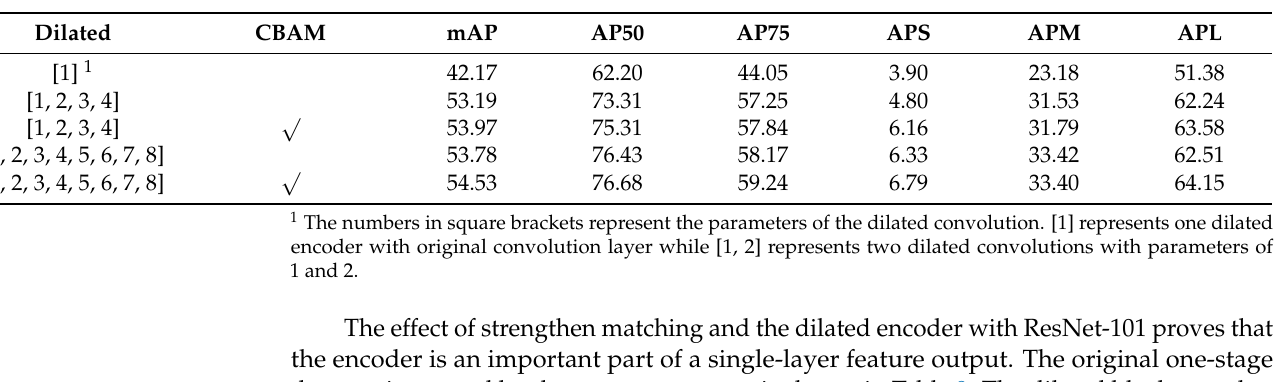
Table 8. Ablation study for the DIOR dataset. Effect with the different dilated block parameters and attention